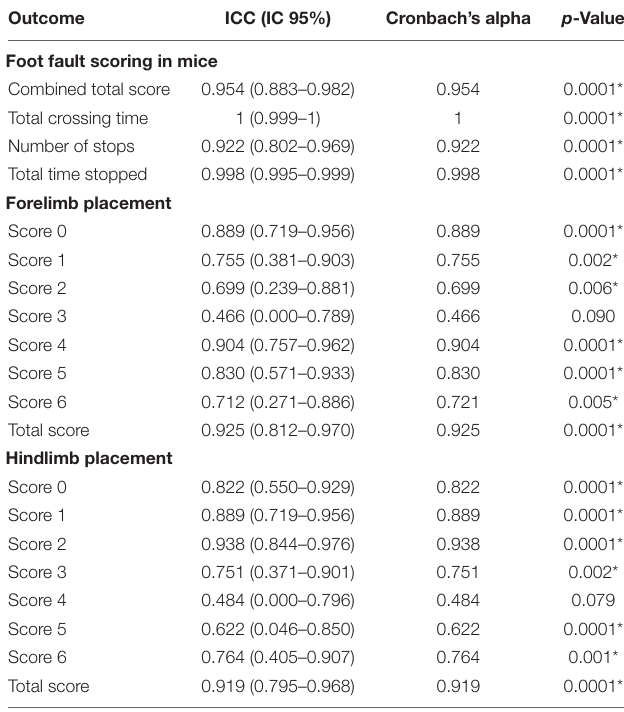
TABLE 3 | Agreement between raters I and II regarding the outcomes (scores) recorded in the LRWT in